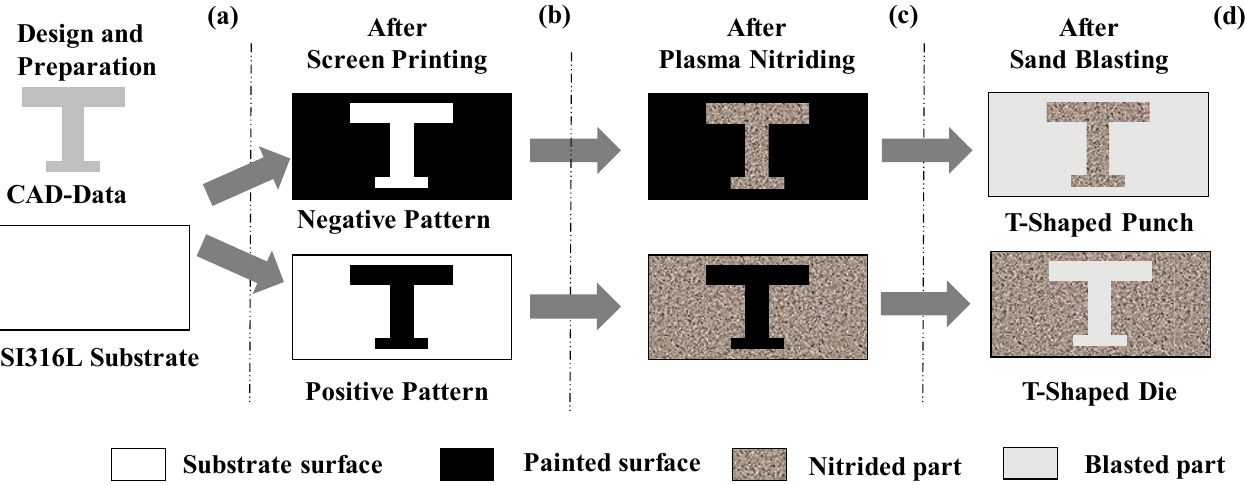
Figure 1. Plasma assisted 3D-printing procedure to fabricate the complex-shaped punch and die without use of mechanical machining and milling. ( a ) Initial AISI316L substrate, ( b ) micropatterning onto substrate surfaces, ( c ) plasma nitriding through unprinted surfaces, and ( d ) blasting to remove un-nitrided parts.